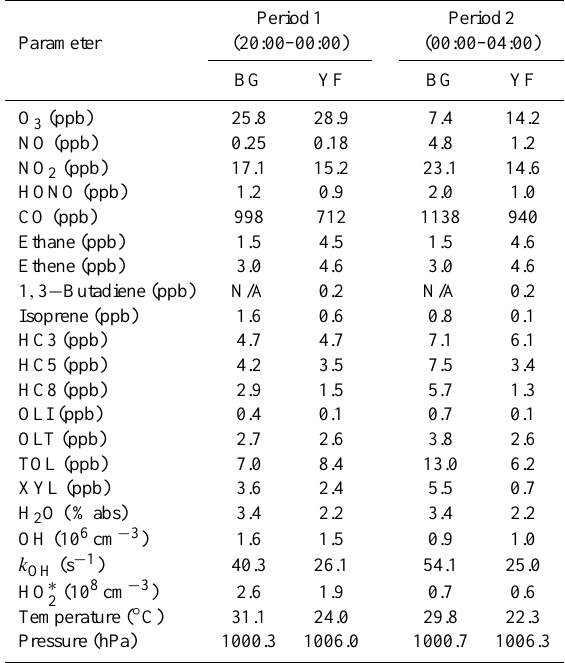
Table 1. Nighttime averaged values of observed trace gases, HO x radicals, and total OH reactivity before (20:00–24:00CNST) and af- ter (00:00–04:00CNST) midnight at the measurement sites in Back- garden (BG) and Yufa (YF).